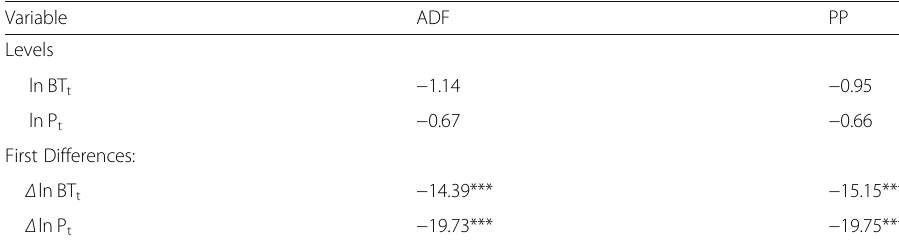
Table 1 Unit root tests Variable ADF PP